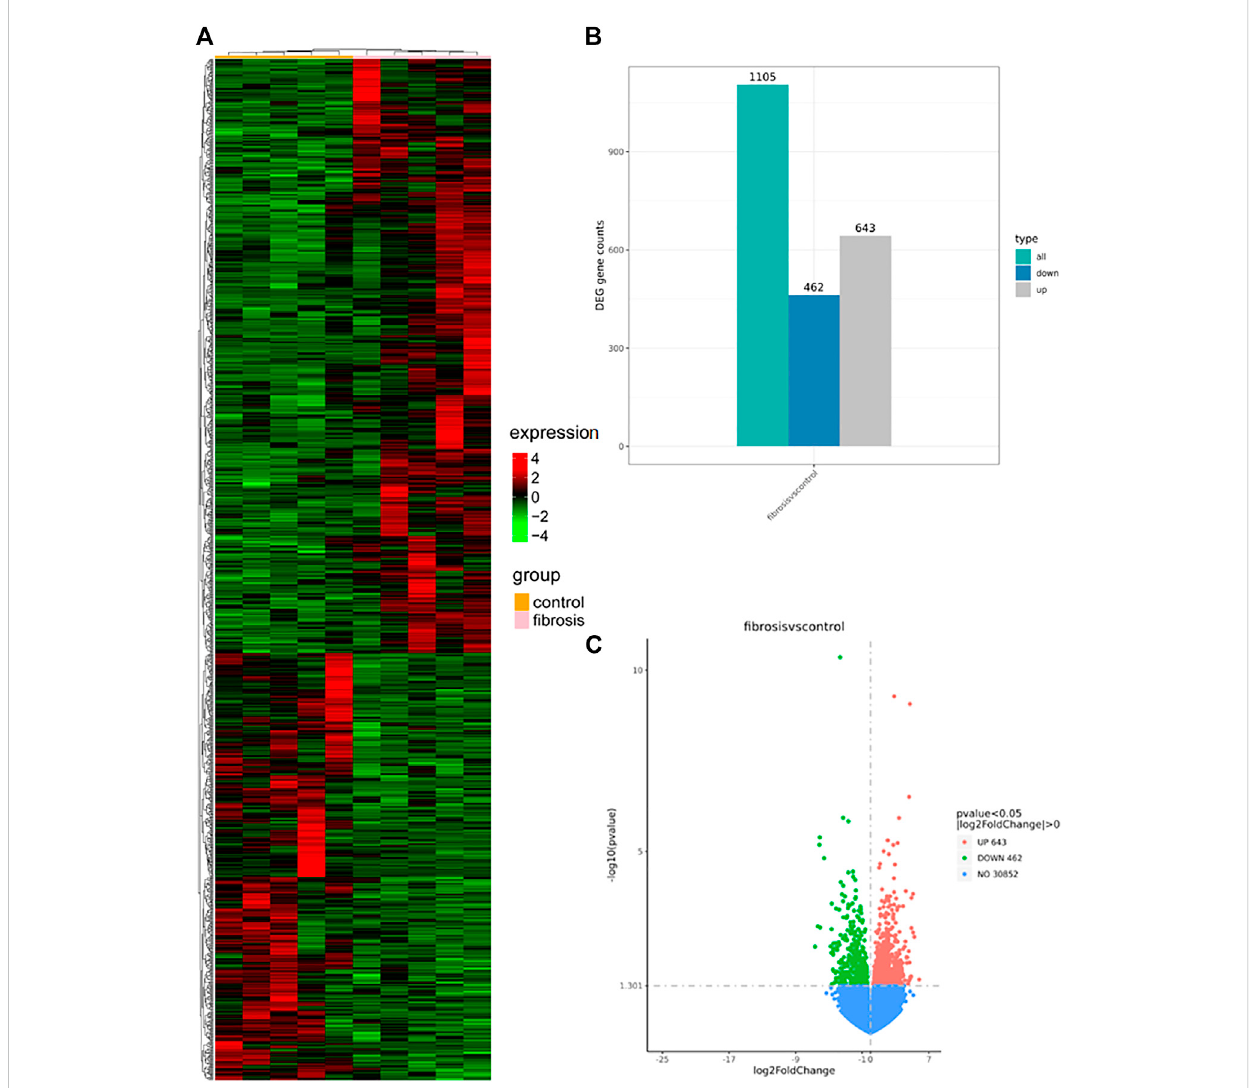
FIGURE 2 Clustering plot (A) , histogram (B) , and a volcano plot (C) were generated using the NovoMagic platform. (A) Clustering map illustrating up- and down-regulated mRNA expression in the HBV-associated liver fi brosis group, with red and green representing selected up- and down-regulated genes, respectively. (B) Histogram mapping ofmRNA expression intheHBV-associated hepatic fi brosisgroup. Grayand bluerepresent selected up-and down- regulated genes, respectively. (C) The volcano plot shows the up- and down-regulation of mRNA expression inthe HBV-associated hepatic fi brosis group, with red and green representing selected up- and down-regulated genes, respectively. DEGs, differentially expressed